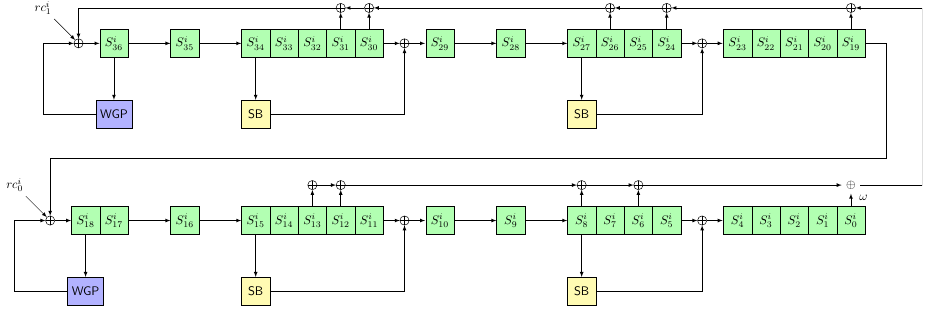
Figure 2: A block diagram of the wage_stateupdate